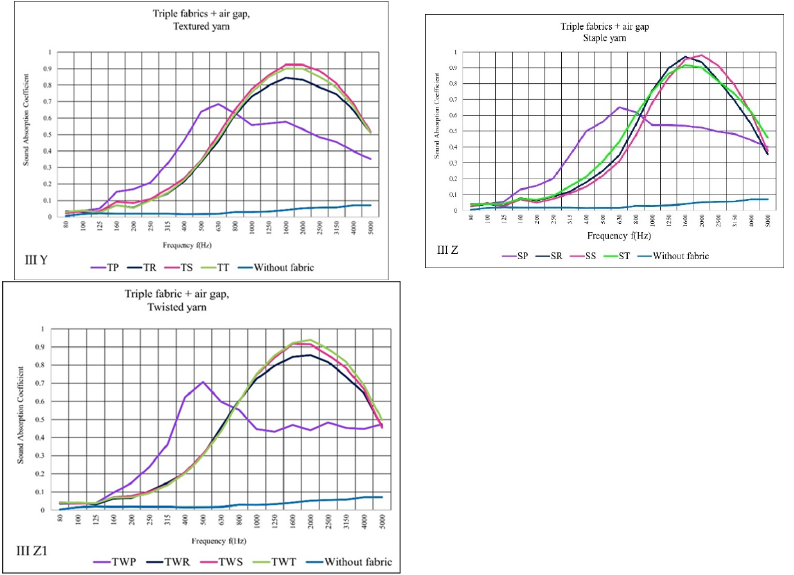
Figure 13. Sound absorption coefficient ( α ) versus frequency f (Hz) result of measurement III variant ( Y – Z1 ) triple woven fabrics + air gap.